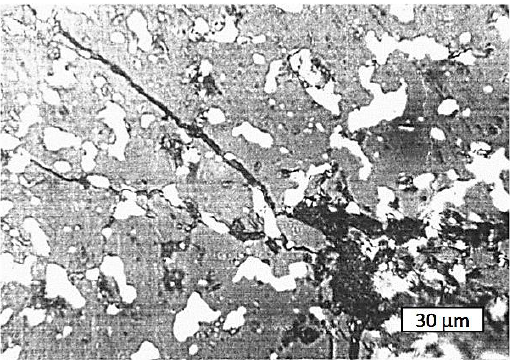
Figure 13. Crack propagation in the Сr 2 O 3 + (Cr,Al) 2 O 3 + 22 wt.% Cr cermet sample sintered at Т = 1600 °С under Р = 30 MPA for t = 10